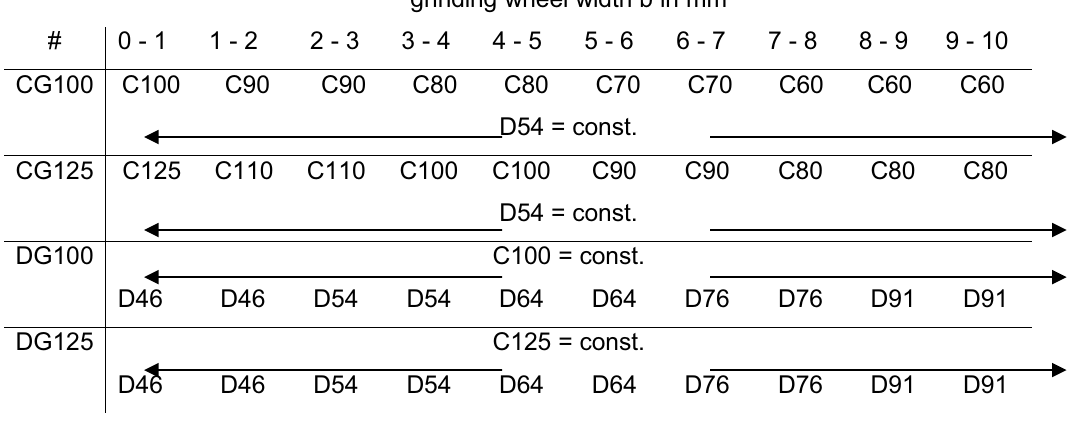
Table 1 Gradients of used grinding